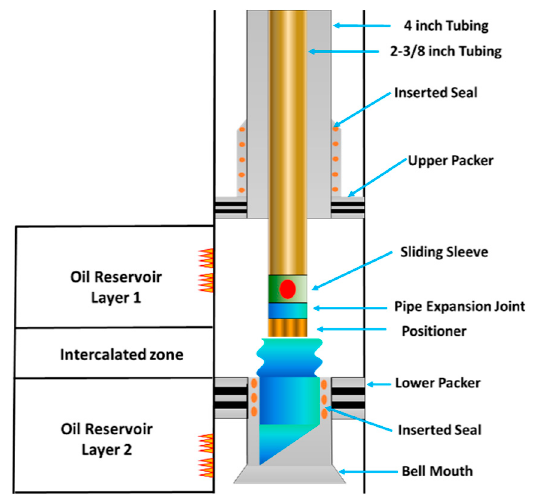
Figure 2. Schematic diagram of dual-tubing injection.